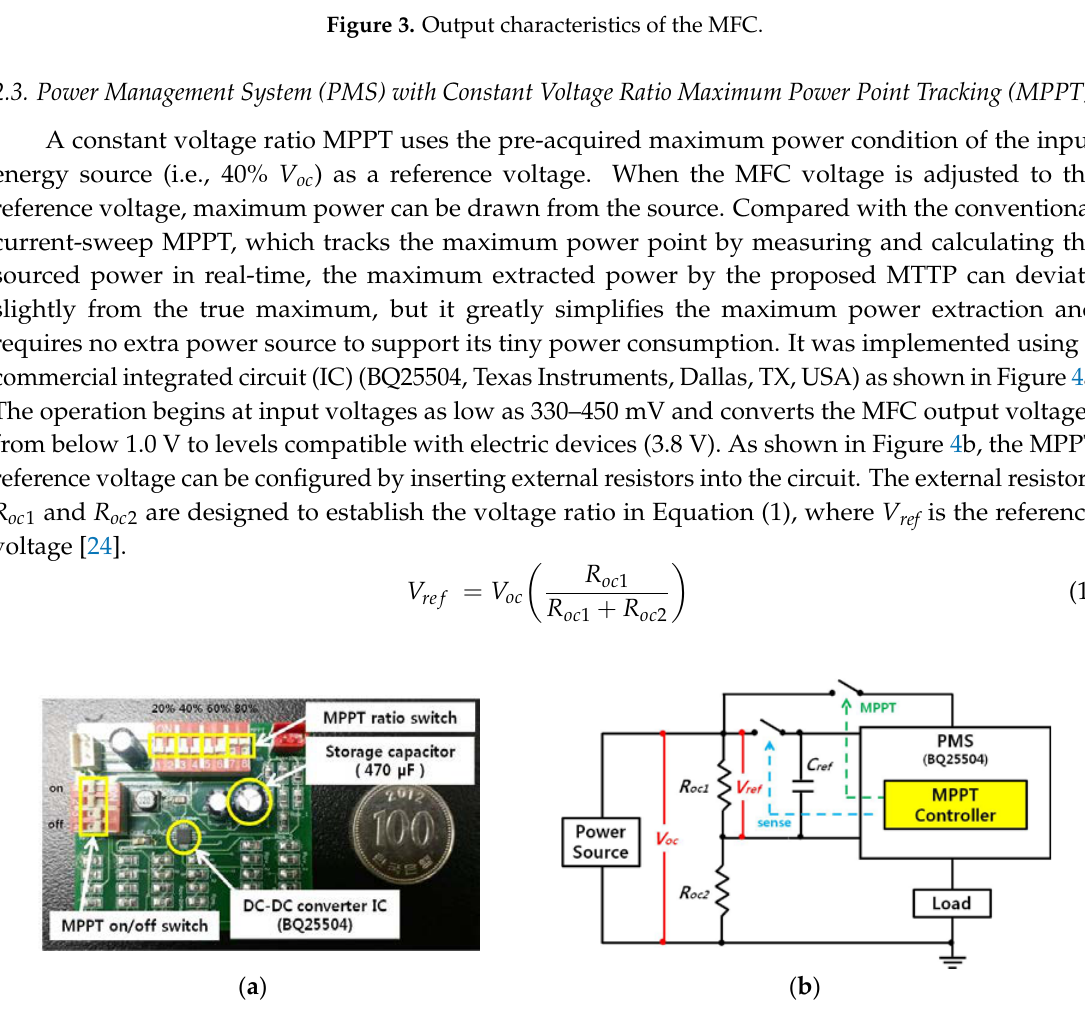
Figure 3. Output characteristics of the MFC.